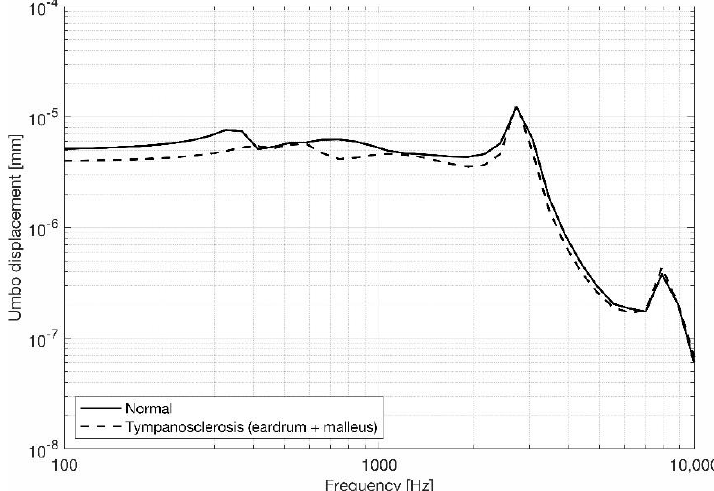
Figure 5. Umbo displacements’ magnitude, comparing the model that was representative of a normal ear and tympanosclerosis affecting the eardrum and the malleus.